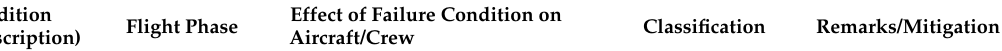
Table A3. ADS FHA for